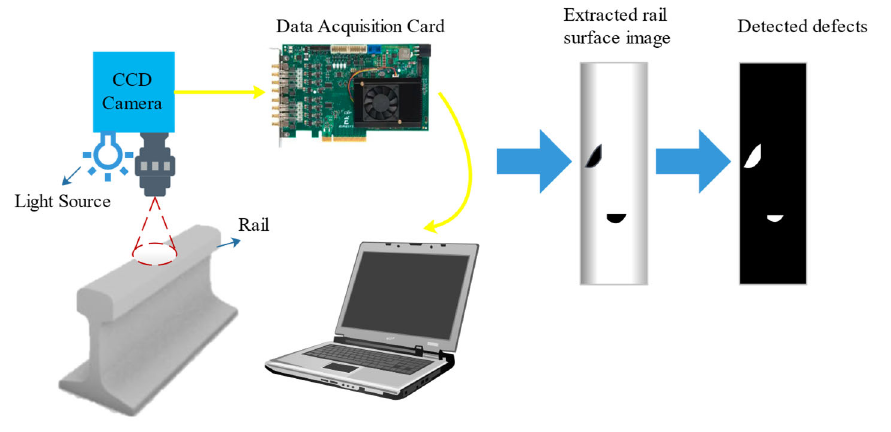
Figure 1. Visual inspection of